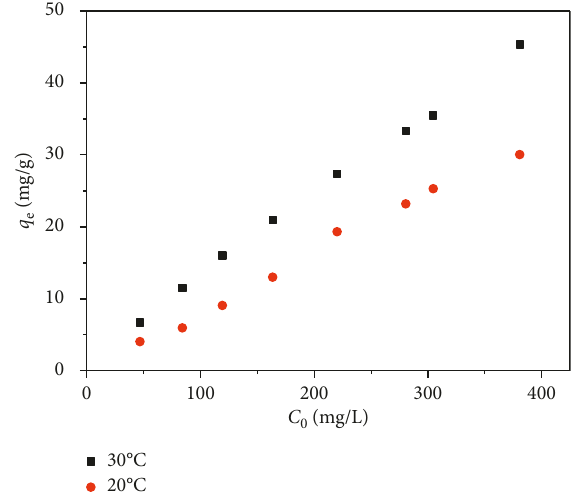
° C, reaction 0 : 142.5mg/L, T: 30 Figure 6: Effect of initial RR-2 concentration (reaction time: 10h and pH: 7).